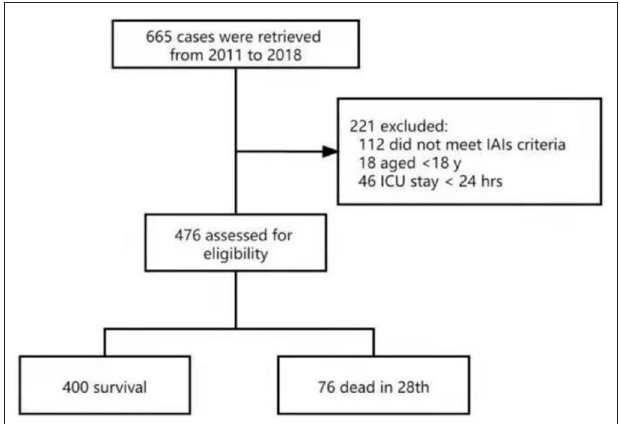
FIGURE 1 | Flowchart of the study